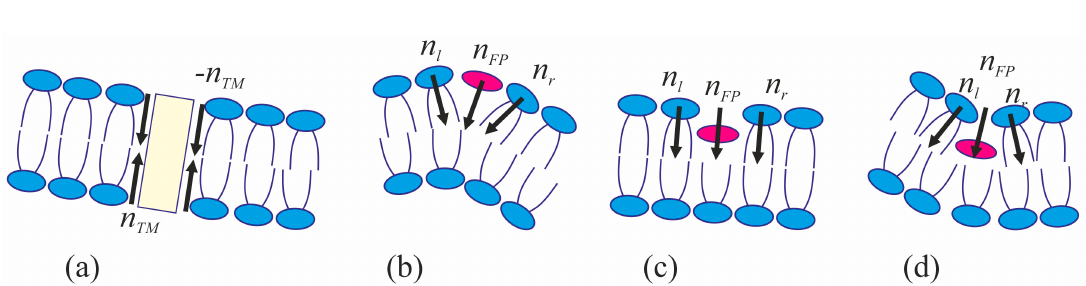
Figure 7. Schematic representation of a fusion peptide in a bilayer. ( a ) transmembrane domain; ( b ) case of shallow incorporation of the fusion peptide; ( c ) intermediate incorporation; ( d ) deep incorporation. The black arrows designate the directions of the boundary directors. Transmembrane domain is represented by light-yellow rectangle, fusion peptides—by red ellipses.